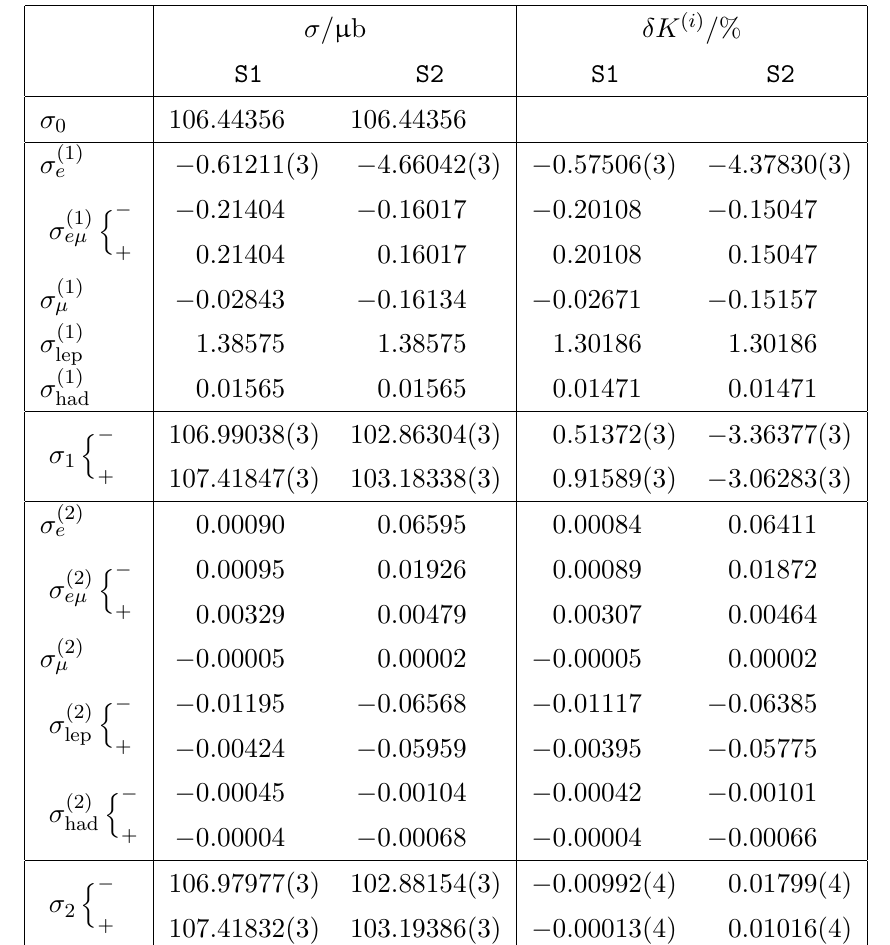
Table 2 . Integrated cross sections for S1 and S2 at LO, NLO, and NNLO. The results are split into photonic, i.e. electronic, mixed and muonic, and fermionic, i.e. leptonic and hadronic, correc- tions. All three leptons are included in the leptonic contributions. When applicable, the different contributions with negative and positive muons are shown. Where no error is given, all digits are significant compared to the precision of the numerical